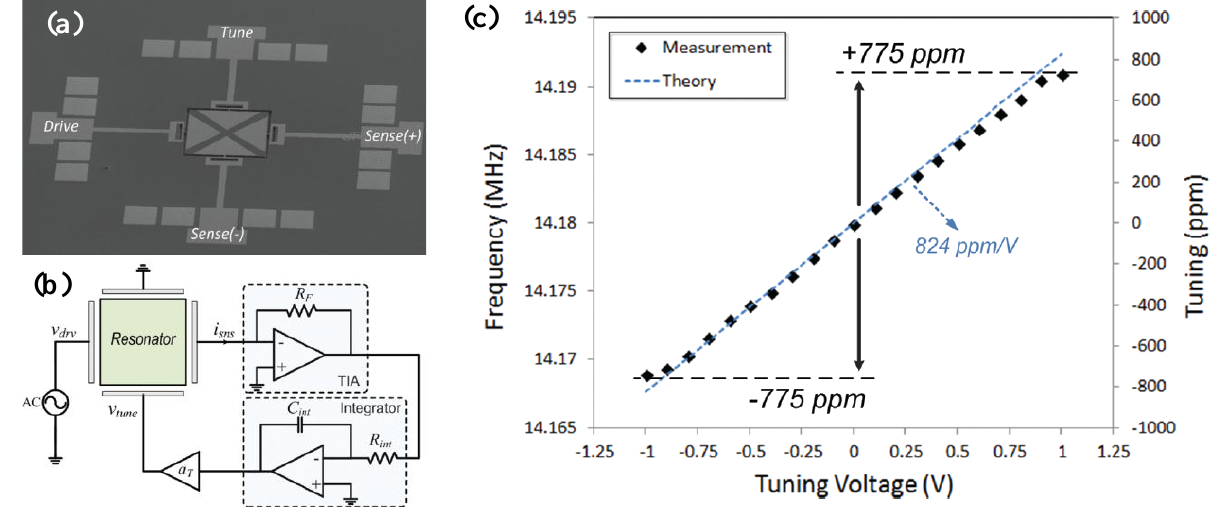
Figure 32. An active feedback-based frequency tuning technique for MEMS resonators reported by Norouzpour-Shirazi et al. [371]. ( a ) SEM of the 4-port AlN-on-Si square resonator; ( b ) a feedback loop is used to tune the frequency of the resonator; ( c ) the measured tuning and theoretical values using the active tuning method. Reused with permission from [371], Copyright 2015,